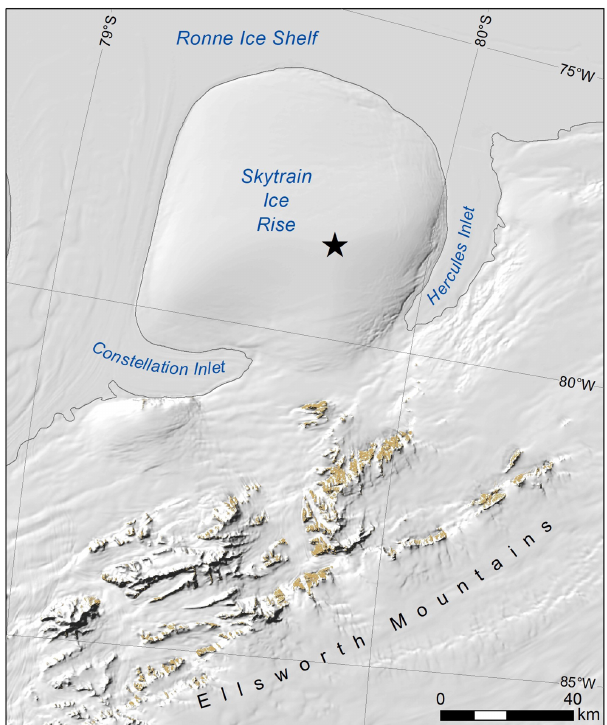
Figure 2. Skytrain Ice Rise. The drill site is marked with a star. Figure reproduced from Mulvaney et al.